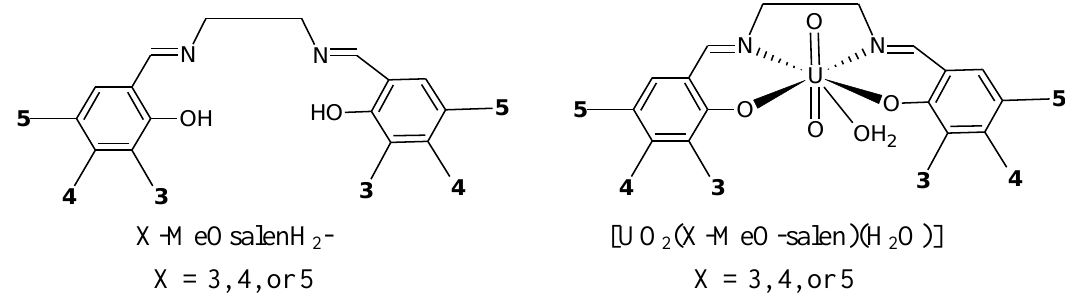
X-MeOsalenH X = 3, 4, or 5